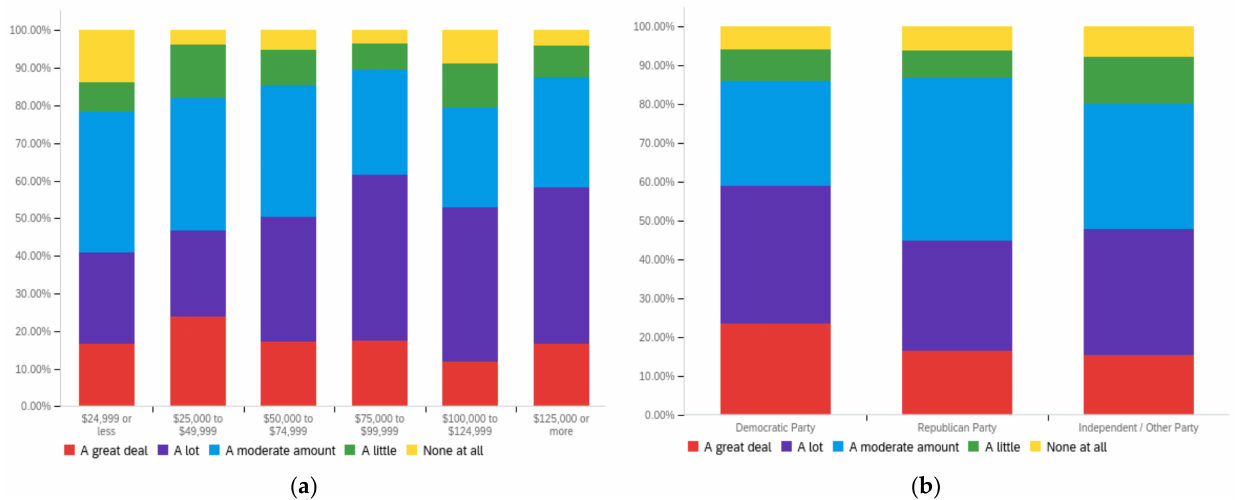
Figure A3. Article title—ideal perception impact by: ( a ) income level (top left), ( b ) political affiliation (top right) and ( c ) online usage (bottom).